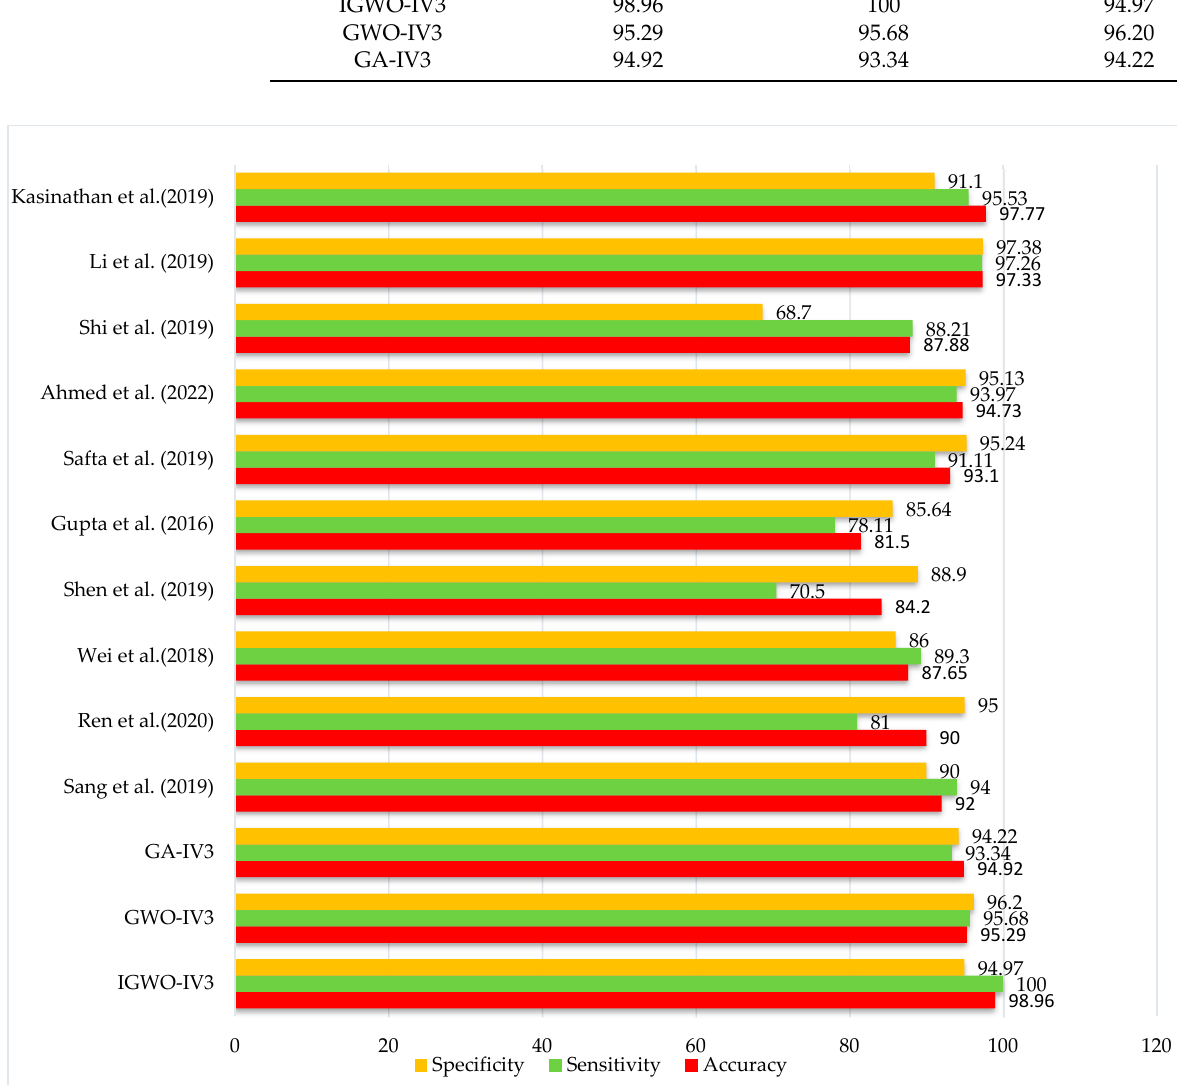
Figure 16. State-of-the-art comparison.